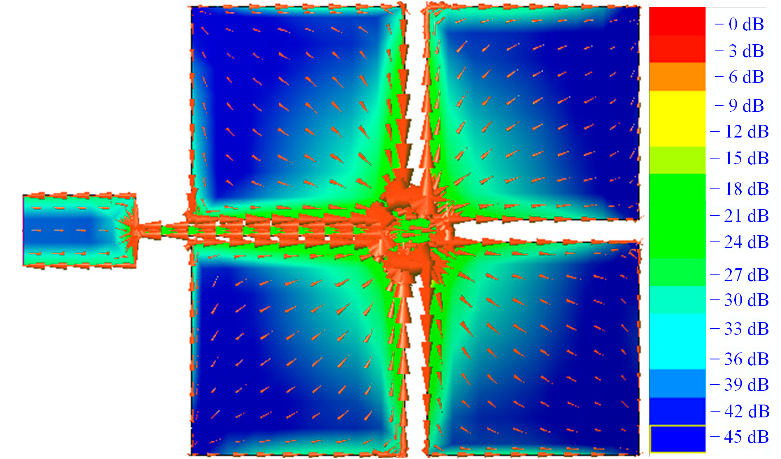
Figure 6. Current distribution for single-band slotted square patch antenna at 2.4 GHz. In addition, the simulated 2D and 3D radiation patterns at 2.4 GHz are shown in Figure 7. It has been noted that the proposed antenna gain with FR-4 substrate is less than 0 dB, while the directivity = 4.72 dB. This gain reduction is due to the low performance of the low-cost FR-4 substrate. The low gain can be overcome using high-quality dielectric material such as RT Duroid 5880. Another antenna is designed on this substrate with the parameters: ε r = 2.2, thickness = 1.6 mm, and loss tangent = 0.0009 to prove the concept. The patch dimensions are optimized to operate at the same 2.4 GHz frequency as: patch length = 24 mm, slot length = 9.4 mm, and slot width = 4.5 mm. A little increase in the patch length is observed due to the decrease in the dielectric constant. The simulated S 11 and 2D radiation patterns of this antenna are shown in Figure 8. A significant increase of 3.95 dB in the gain is